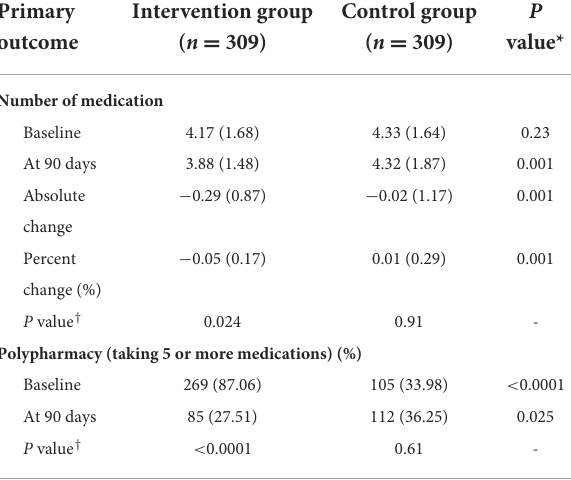
TABLE 2 The number of medication and polypharmacy of elderly patients with multimorbidity.